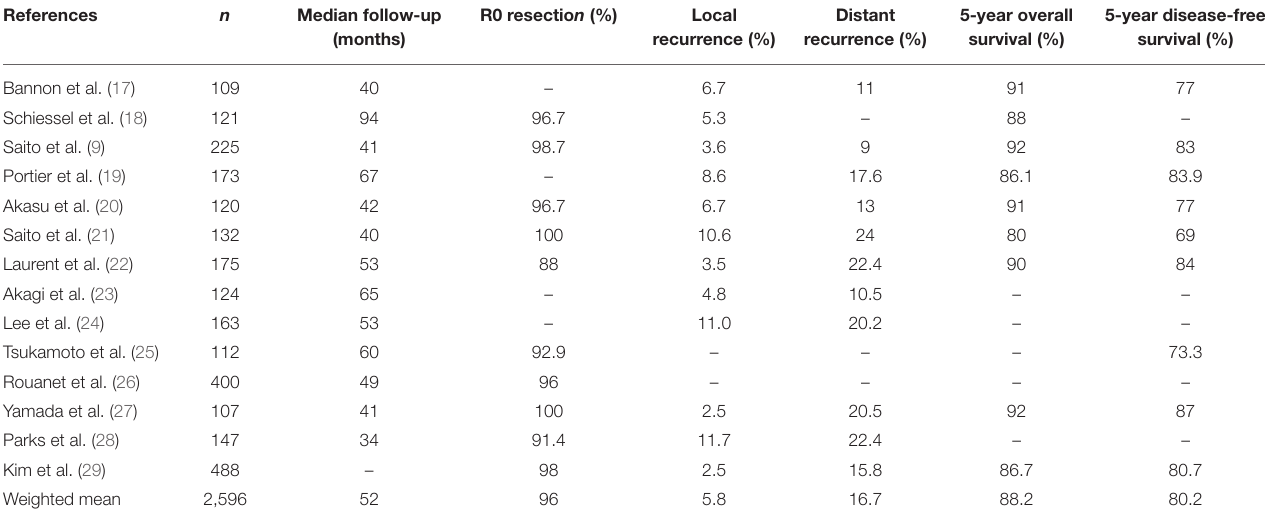
TABLE 1 | Oncological outcomes after intersphincteric resection from studies including at least 100